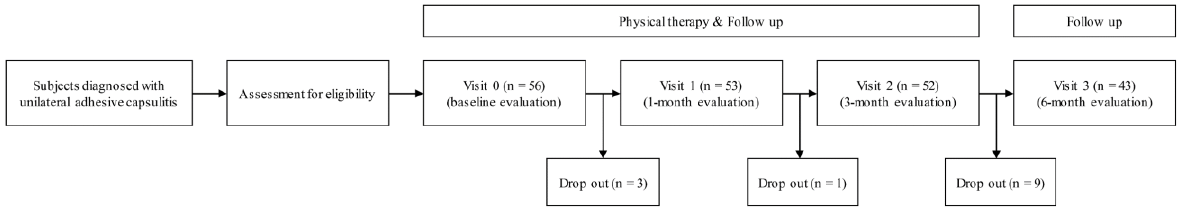
Figure 1. Flow chart of the single-arm, prospective study.